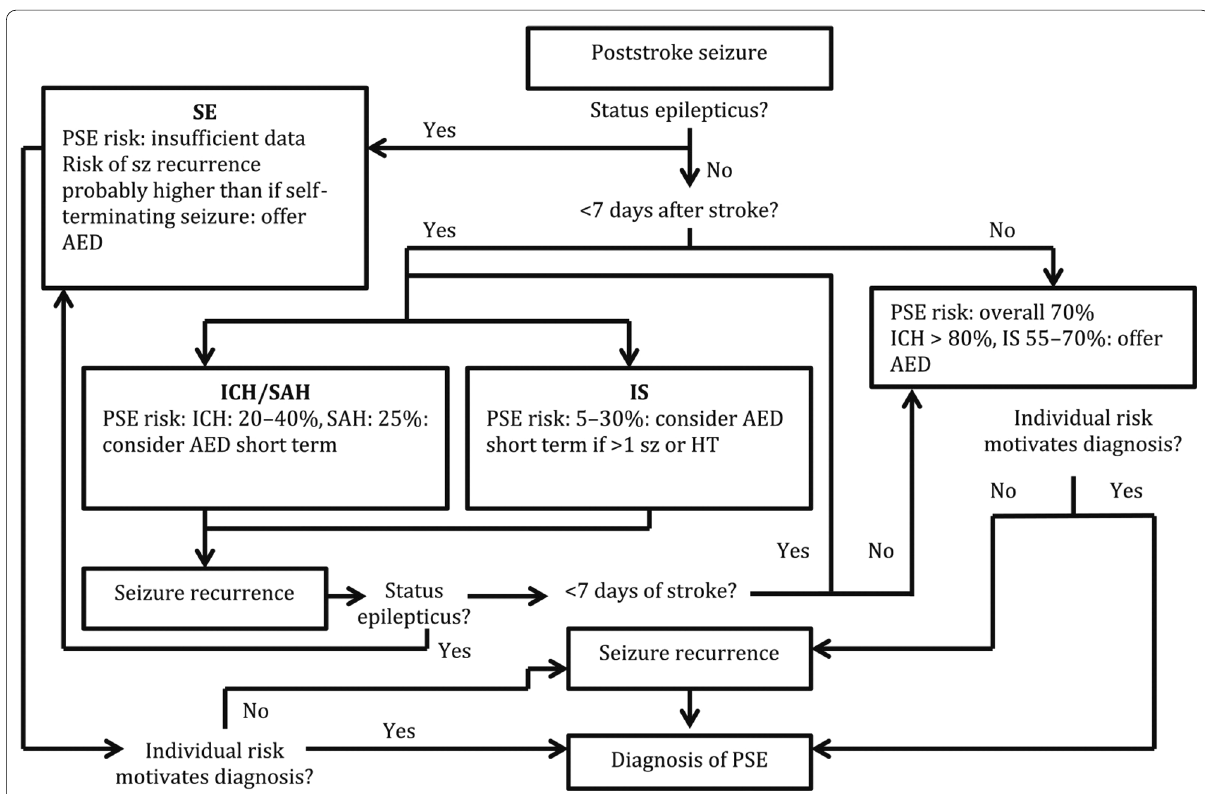
Fig. 1 Risk-based therapeutic strategy for post-stroke seizures (PSS). AED: anti-epileptic drug, ICH: intracerebral haemorrhage, IS: ischaemic stroke, HT: haemorrhagic transformation, PSE: post-stroke epilepsy, SAH: subarachnoid haemorrhage, SE: status epilepticus, Sz: seizure. Figure adapted from Zelano J. 47, Ther Adv Neurol Disord 9(5) pp 424–435, copyright © 2016 The Author. Reprinted by permission of SAGE